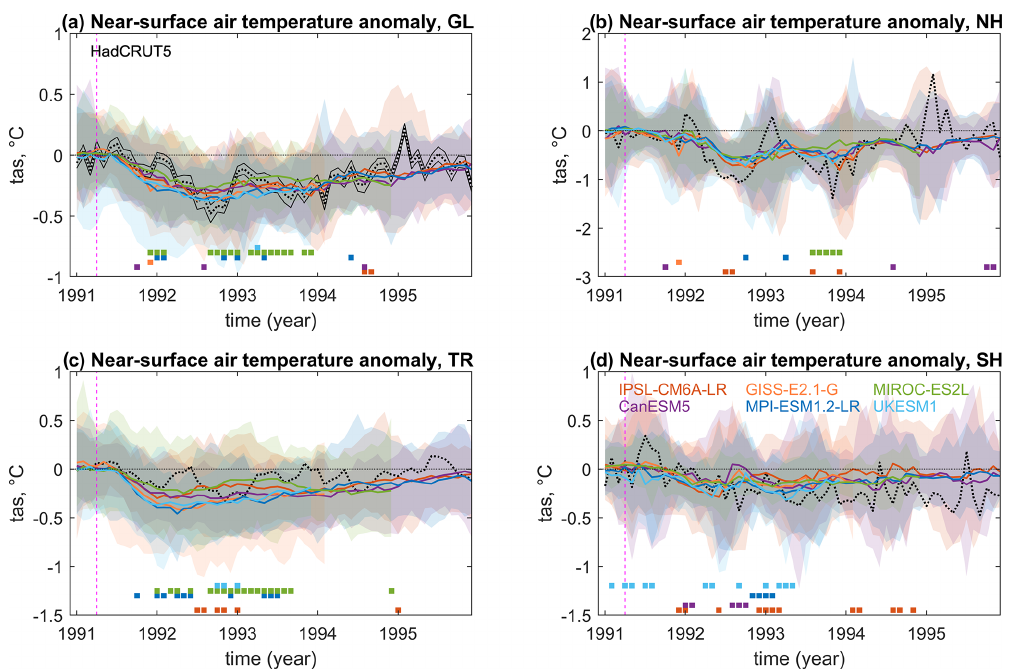
Figure 7. Same as in Fig. 5 but for near-surface air temperature (tas). Observed HadCRUT anomalies (ensemble-means as deviations from the 1990 average calculated from detrended time series, see methods) are plotted as dotted black lines for comparison; uncertainty estimates are also provided for GL (continuous black